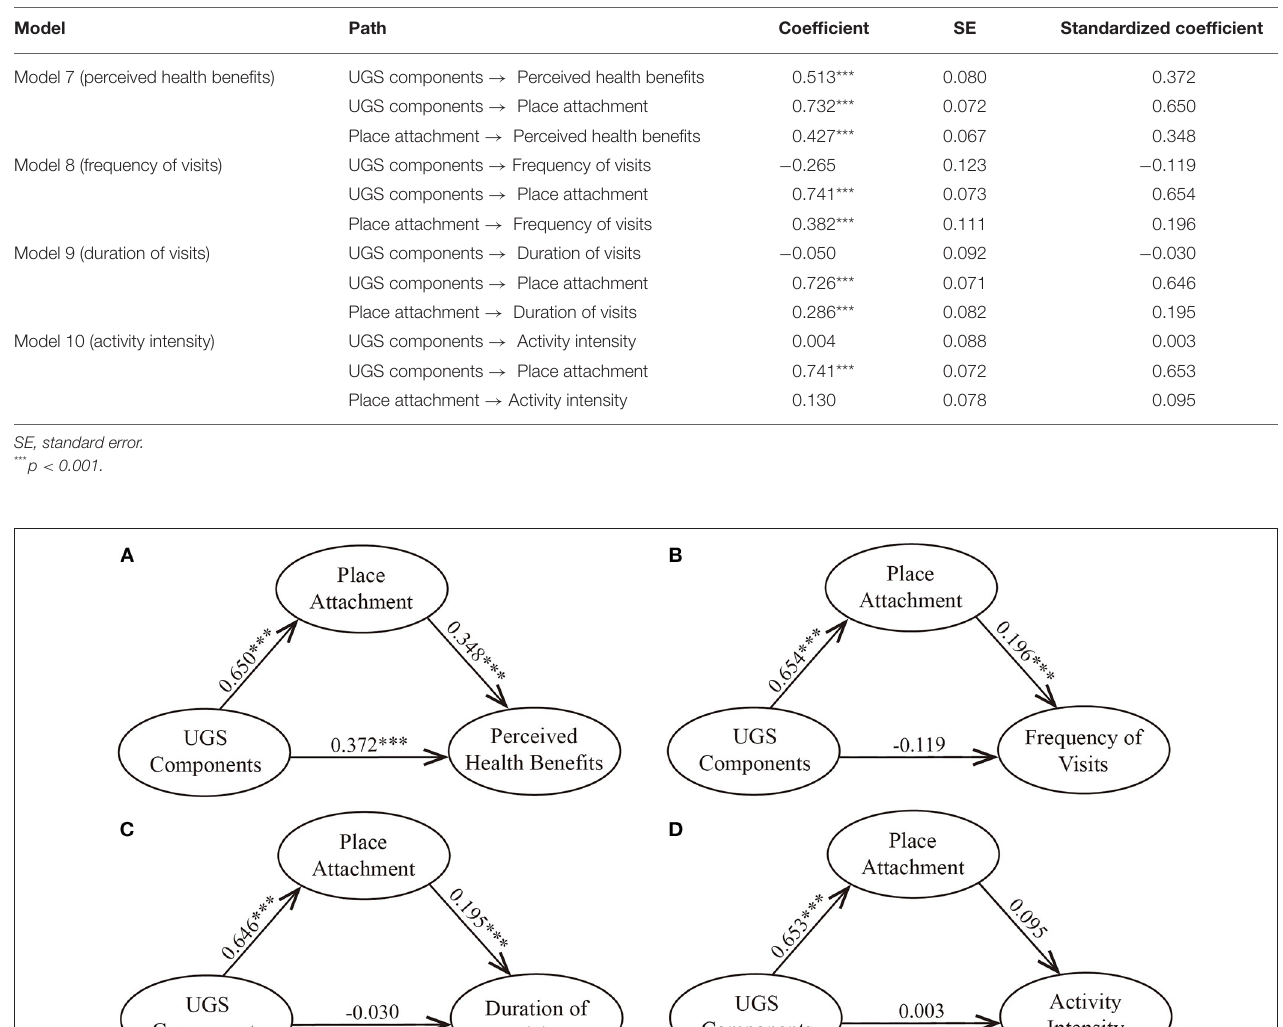
TABLE 7 | Path analyses.